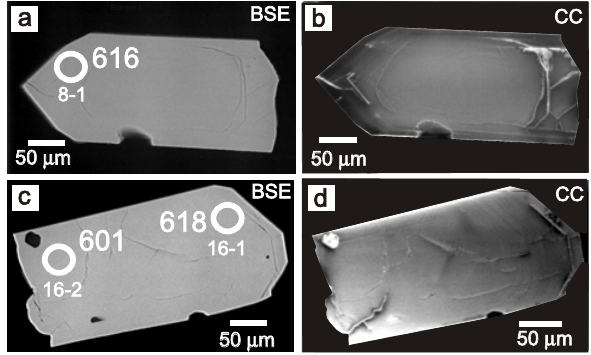
Fig. 2 – Backscattered electron (BSE) and charge contrast (CC) images of zircon grains from Sample 1. Circles indicate spot location; ages indicated in Ma. CC images were blackened with computer